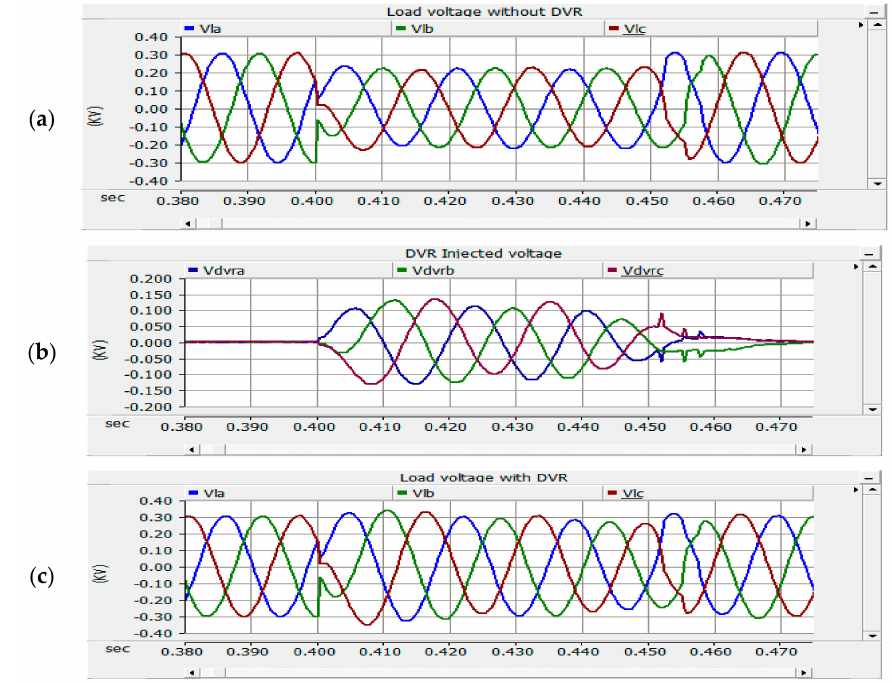
Figure 14. 40% symmetrical phase voltage sag and compensation: ( a ) load voltage without DVR; ( b ) DVR injected voltage; ( c ) load voltage with